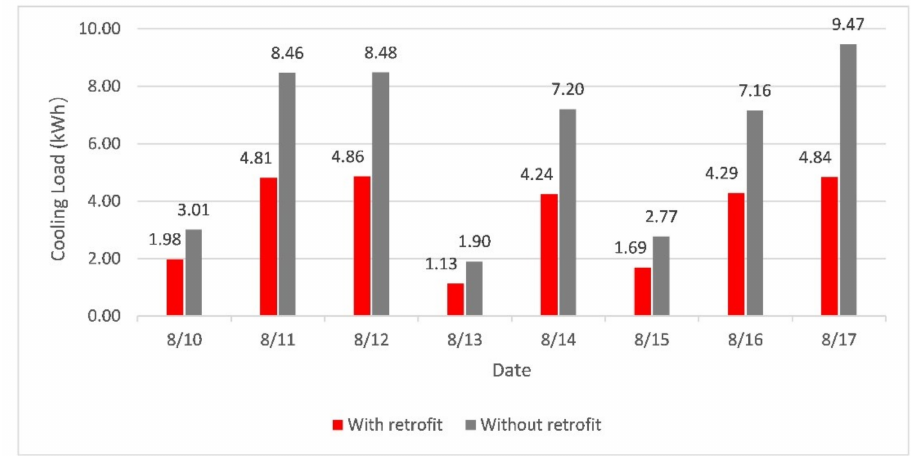
Figure 13. Comparison of daily cooling load in the south bedroom.